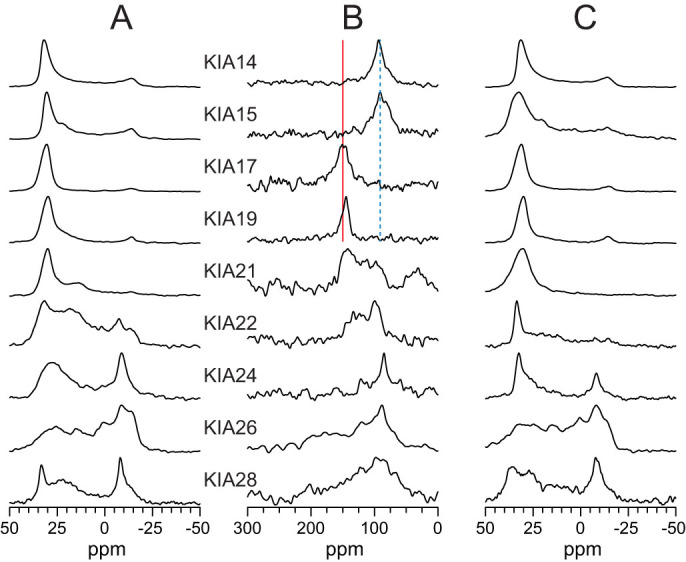
Solid-state NMR spectra of KIA peptides in DMPC at P/L = 1:20.(A) 31P-NMR spectra before 15N-NMR. (B) 15N-NMR spectra. (C) 31P-NMR spectra after 15N-NMR. The 15N-NMR signal of KIA14 and KIA15 at 90 ppm (blue dotted line) is typical of the surface-bound state. It shifts to 150 ppm (red line), indicating an inserted state for KIA17 and some longer peptides. For KIA22 and the even longer peptides, broad powder line shapes are seen in 15N-NMR (with a peak also at 90 ppm), and the 31P-NMR spectra show a perturbed lipid bilayer.